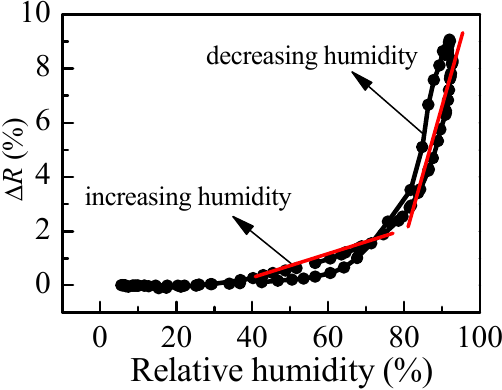
Figure 5. Variation of reflectance of P2 thin film with thickness of 92 nm with humidity.